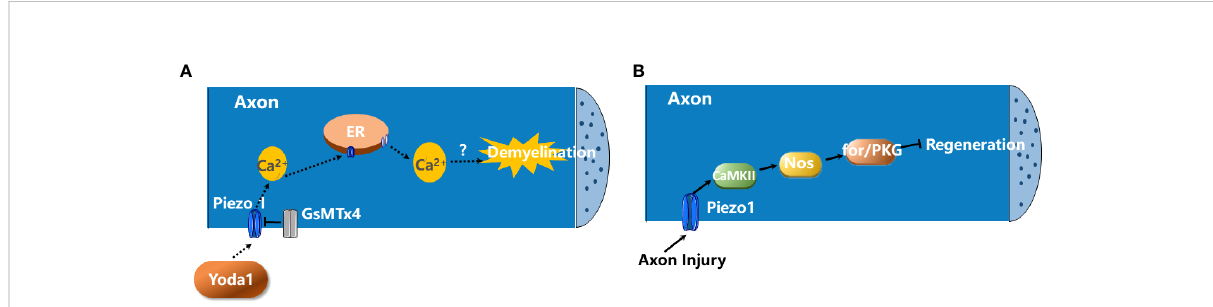
FIGURE 1 The roles of Piezo1 in demyelination and axon degeneration. (A) The activation of Piezo1 channels in axon negatively regulates CNS myelination. The activation of Piezo1 channels in axon by Yoda1 promotes the in fl ux of extracellular Ca 2+ into the neuron which, in turn, triggers Ca 2+ -induced Ca 2+ release (CICR) from ER. This contributes to the demyelination of CNS axons. GsMTx4 blocks Piezo1 activity and prevents the demyelination (57). (B) Piezo1 activation inhibits axon regeneration. Upon axon injury, Piezo1 is recruited to the growth cones and inhibits axon regeneration via the CaMKII-Nos-PKG pathway